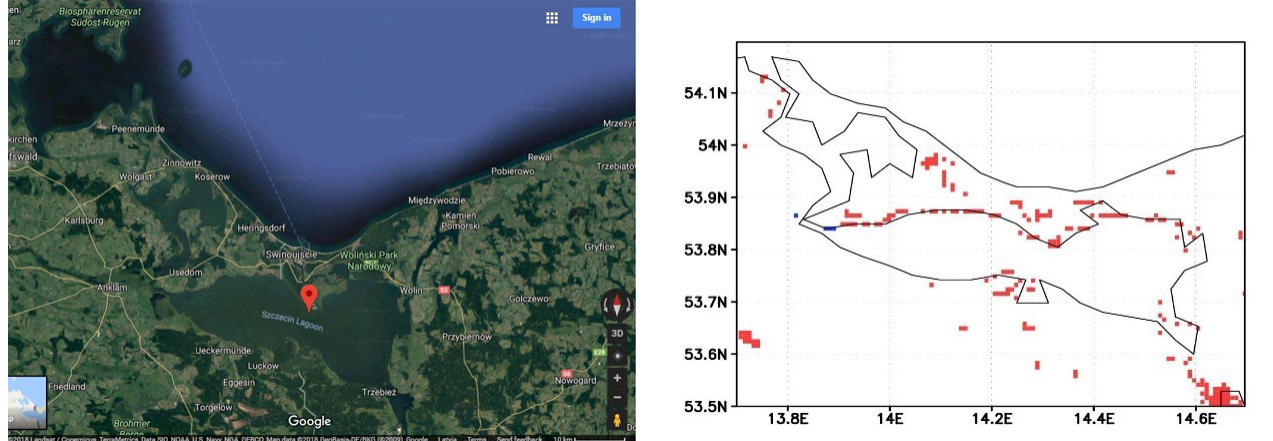
Figure 3. Oder Bay Lagoon on Google Earth (to the left) (Google Earth, https://earth.google.com/web/, 2019) and on ECOCLIMAP2 (to the